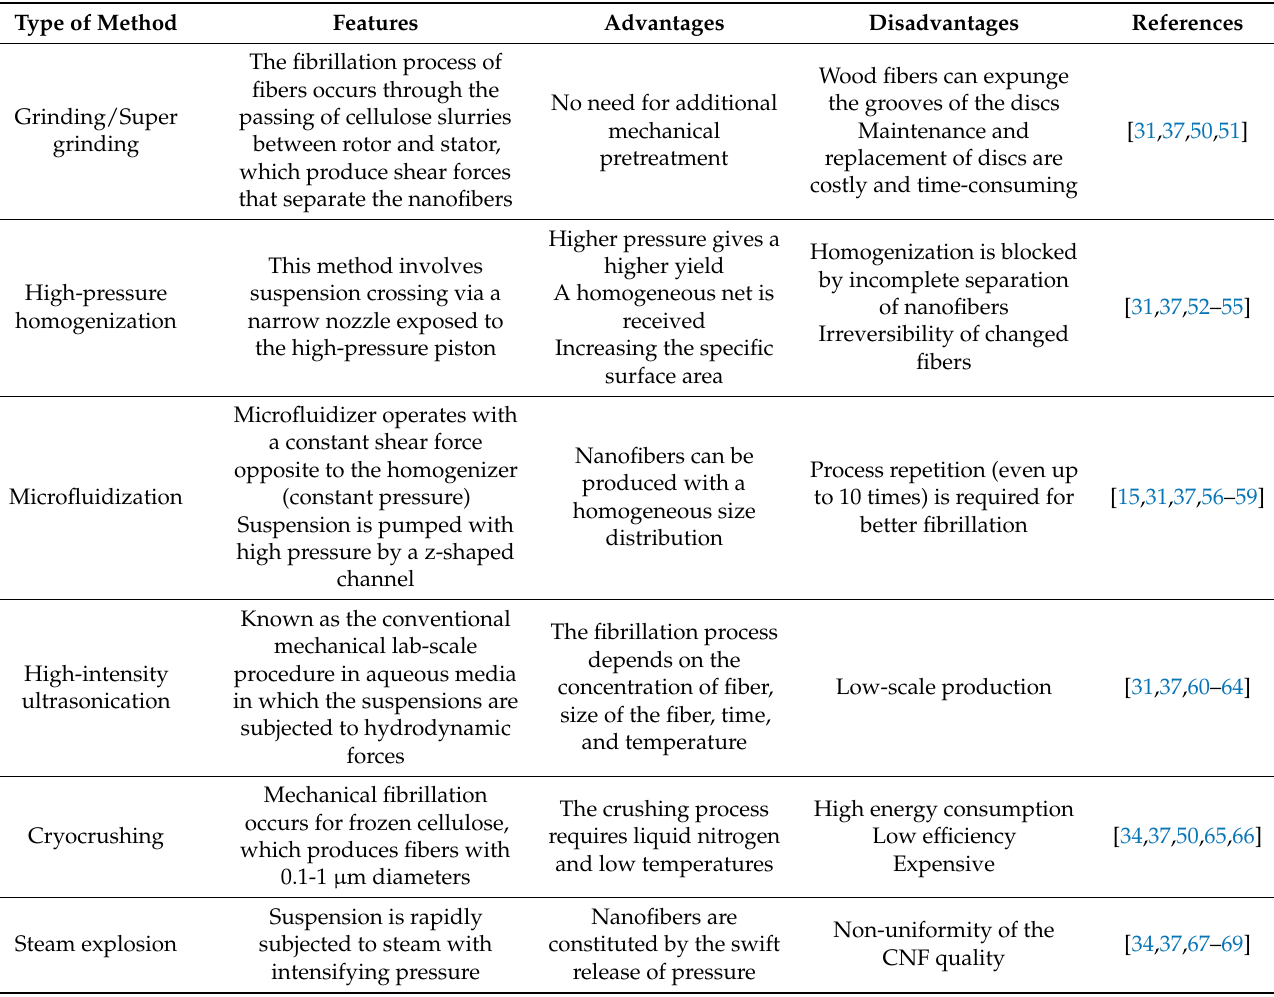
Table 1. Outstanding properties of commonly used procedures for nanocellulosic substance